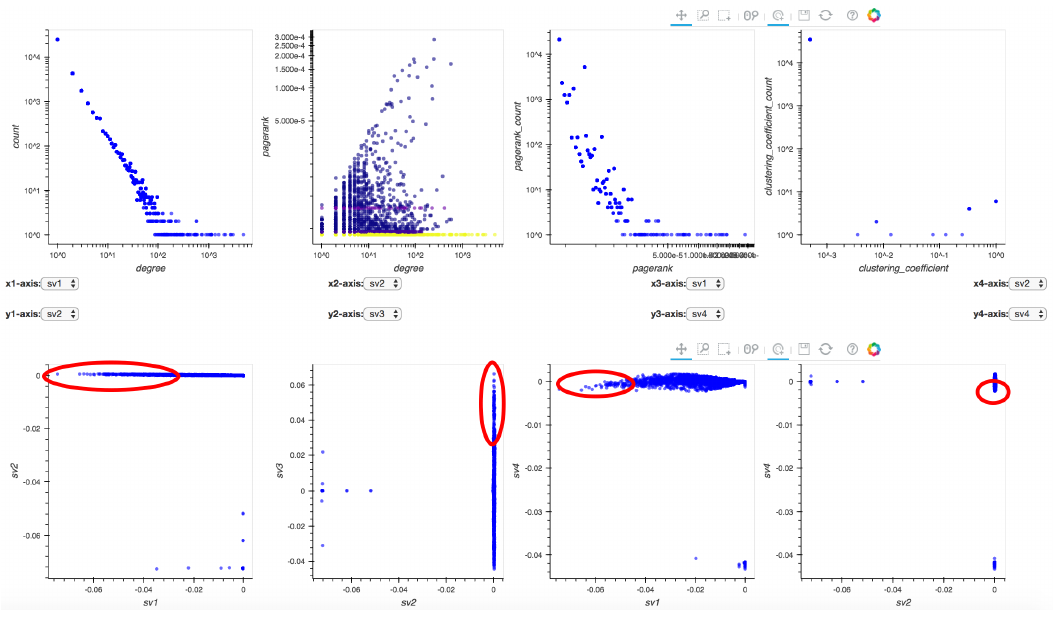
Figure 13. Analysis of Twitter retweet network: suspicious patterns are marked in red